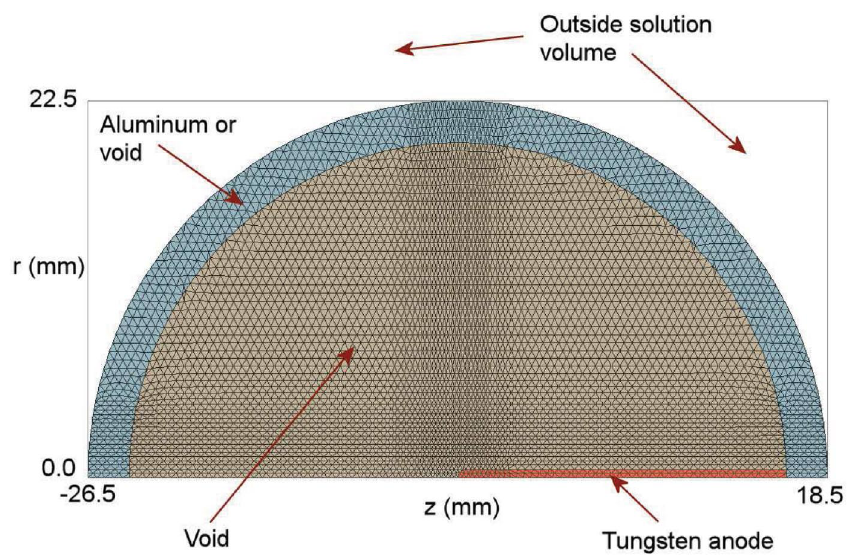
FIG. 8. (Color) GAMBET geometry mesh for the CRAD baseline